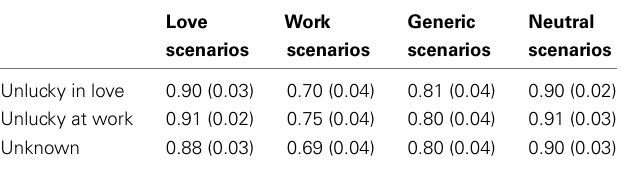
Table 1 | Mean faux pas recognition accuracy by type of scenario and